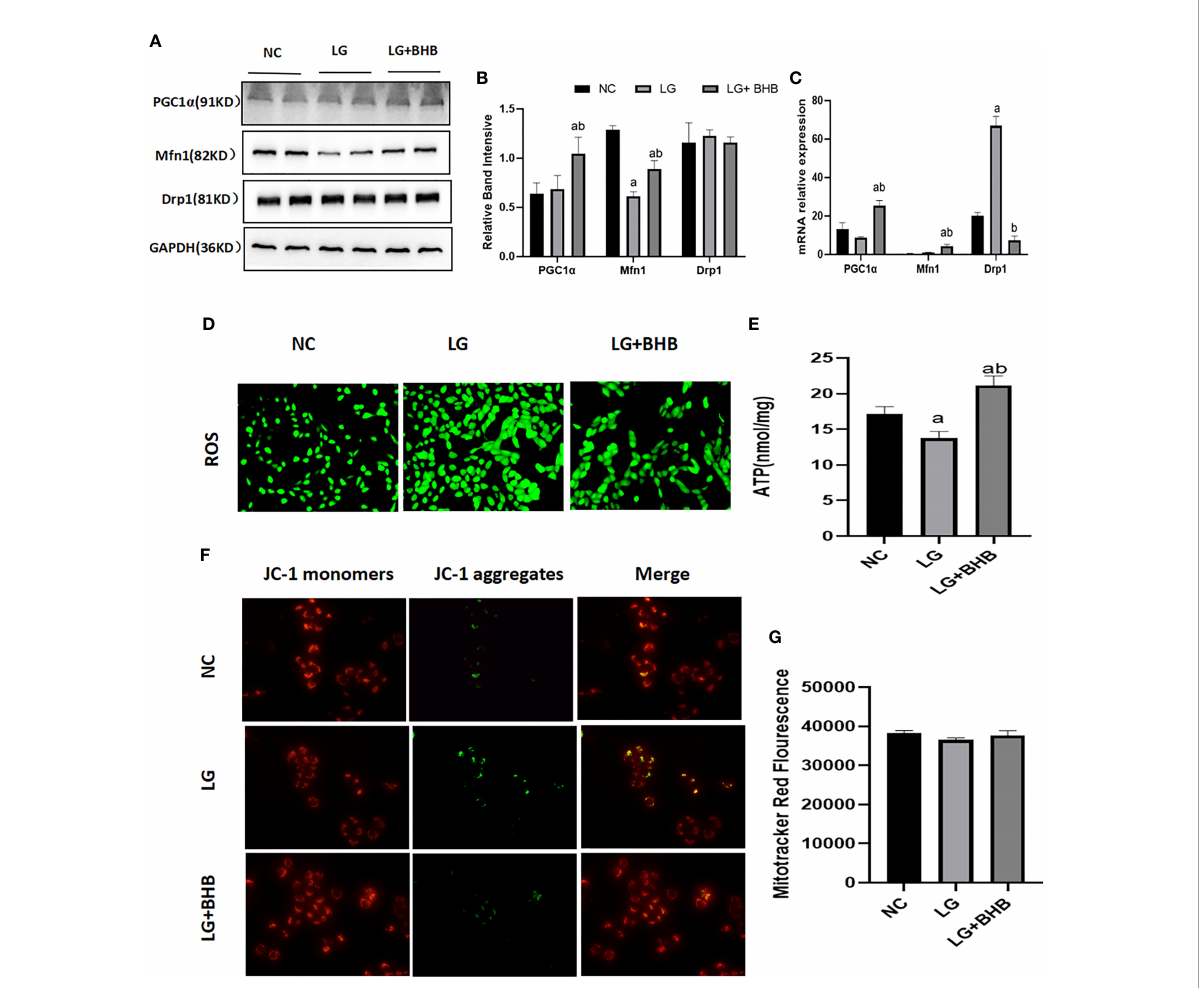
FIGURE 4 Effect of BHB on the mitochondrial function in HK2 cells under low glucose condition. (A – C) Expression of PGC1 a , Mfn1, and Drp1 in HK2 cells with or without 2 mmol/l BHB; (D – G) Changes of ROS, ATP production, mitochondrial membrane potential and mitochondrial number. a p < 0.05, compared with the NC group; b p < 0.05, compared with the LG